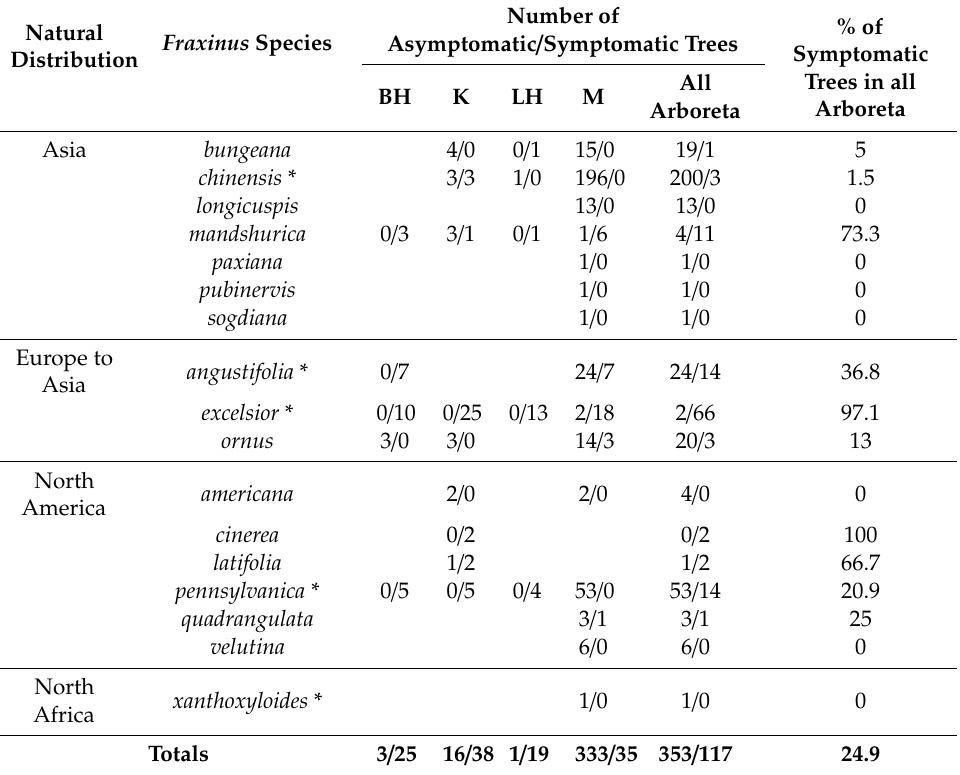
Table 3. Fraxinus species with and without ash dieback symptoms in study sites. Natural Fraxinus Distribution